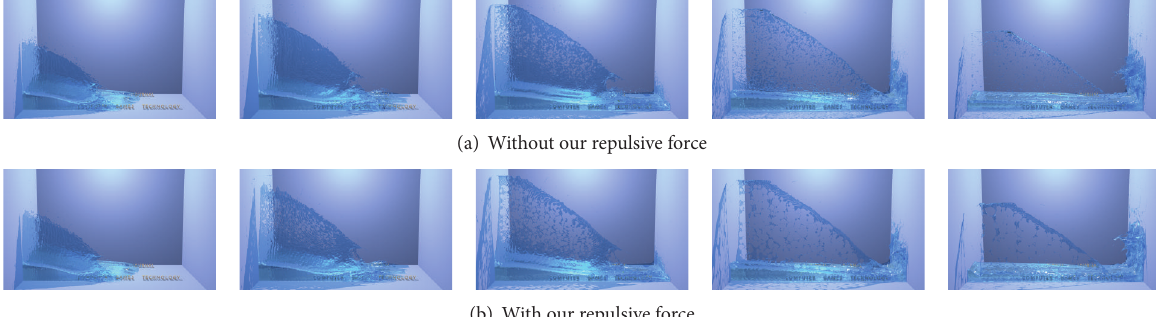
Figure 4: Corner breaking dam (a) without repulsive force and (b) with repulsive force. These scenarios are simulated using our sleepy WCSPH. Note that the fluid surface is now more naturally reconstructed and surface tension like effects can be achieved in the lower figures.